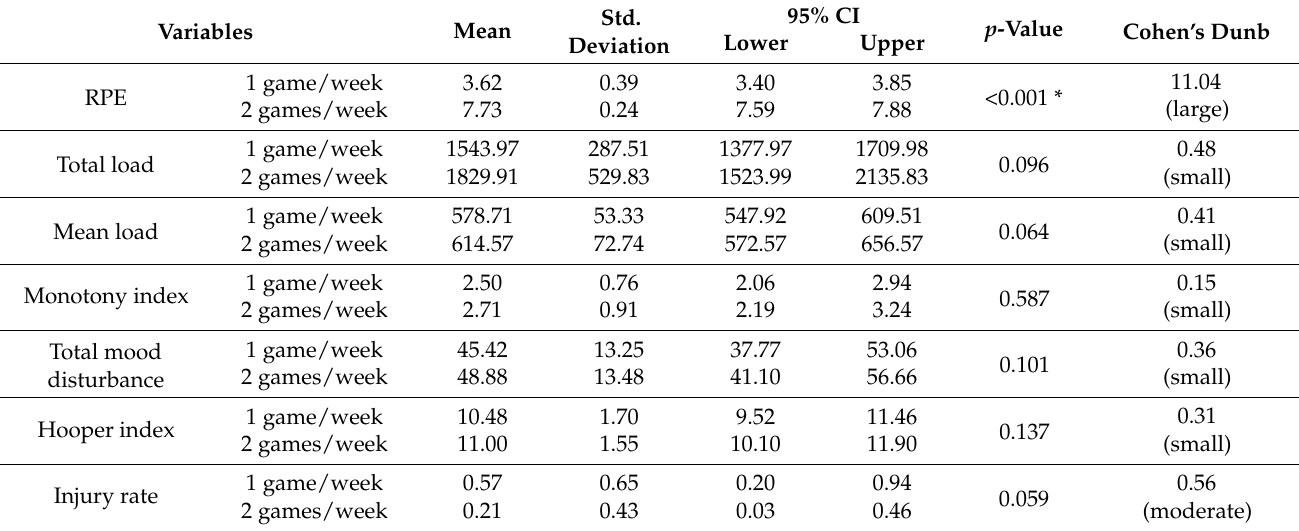
Table 2. Mean, standard deviation (Std. Deviation), and 95% confidence interval (CI) of the dependent variables. Additionally, the significance of the differences between participating in one and two games per week in elite soccer players.